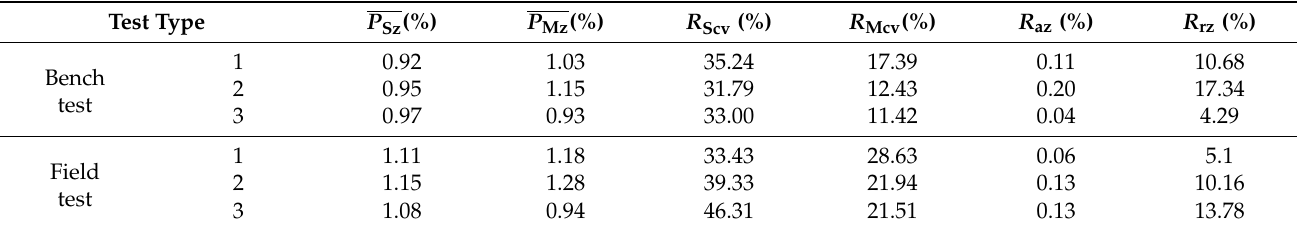
Table 3. Statistical data of the detection results of wheat impurity rate.